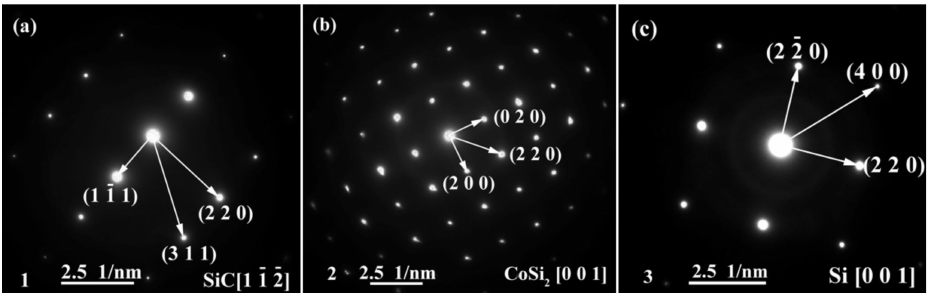
Figure 10. SAED patterns of “1”, “2”, and “3” marked in Figure 9a showing: ( a ) SiC, ( b ) CoSi 2 , and ( c )